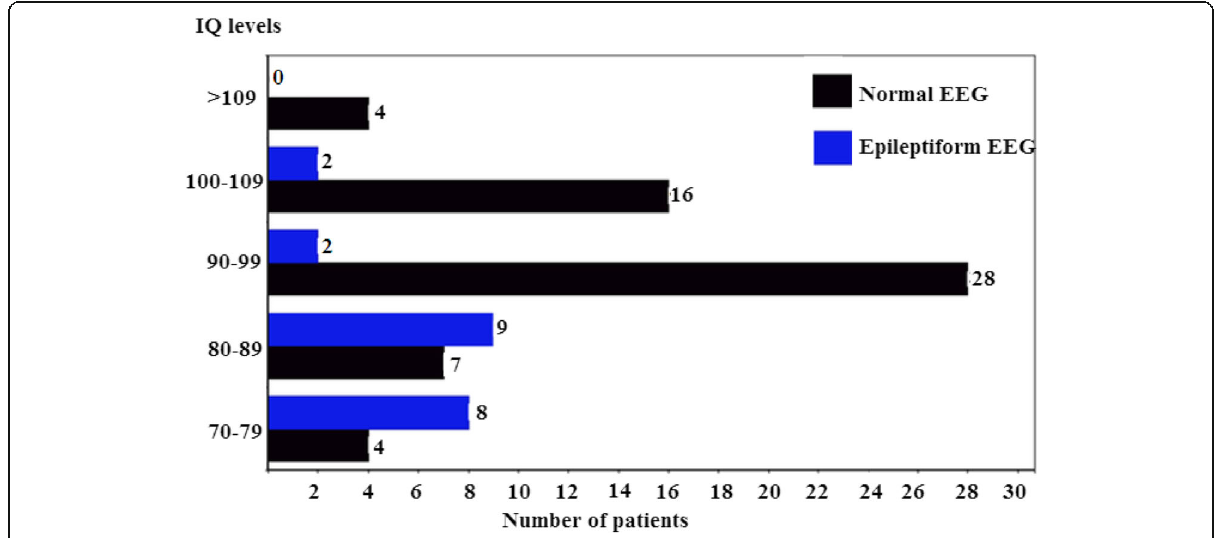
Fig. 2 IQ levels in cases with epileptiform EEG and cases with normal EEG